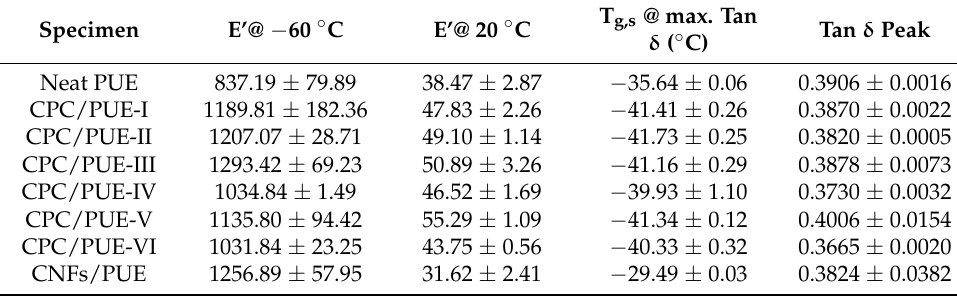
Figure 5. Compression modulus and compression resilience rate of PUE composites ( a ) at different concentrations of CC-PEI, ( b ) at different content of CC-PEI@CNFs, ( c ) experimental graphs of PUE composites at different concentrations of CC-PEI, ( d ) experimental graphs of PUE composites at different content of CC-PEI@CNFs, ( e ) stress–strain curves of PUE composites at the concentration of CPC-2 and magnified area of the top 0.2 strain, ( f ) static absorption energy of PUE composites. Table 4. Dynamic mechanical properties of neat PUE and its